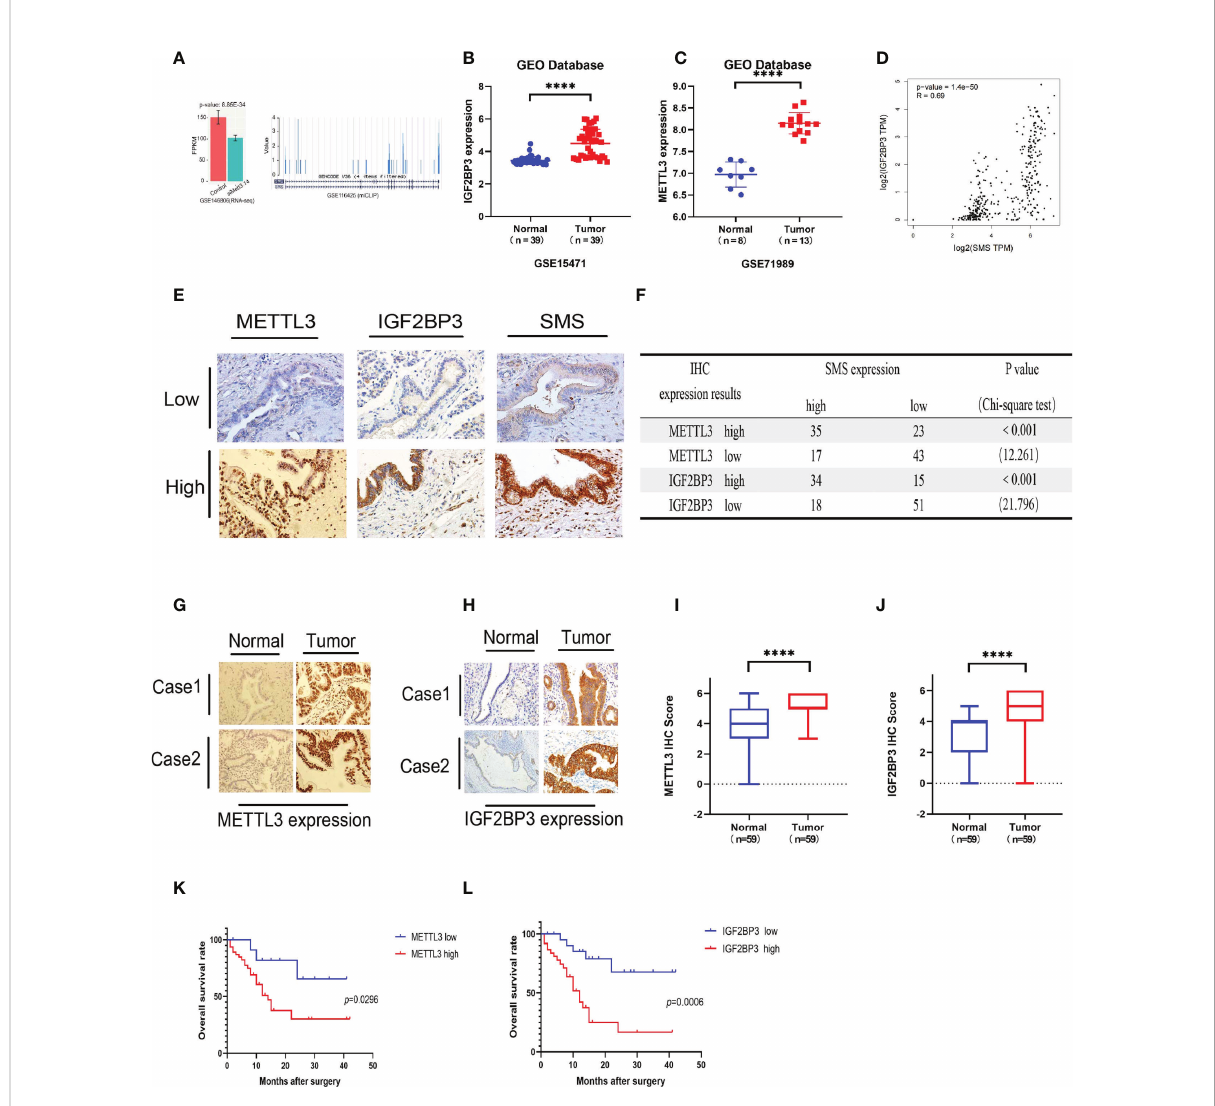
FIGURE 4 METTL3 and IGF2BP3 are highly expressed in pancreatic cancer and predicts poor prognosis of pancreatic cancer patients. (A) The expression of SMS in the METTL3 and METL14 double knock chips in the GEO database. (B, C) The expression of METTL3 and IGF2BP3 in cancer tissues and adjacent tissues. (D) The GEPIA database showed that IGF2BP3 was positively correlated with SMS mRNA expression. (E) The expressions of METTL3/IGF2BP3 and SMS in tissues of PDAC patients were evaluated by IHC. (F) The correlation between METTL3/IGF2BP3 and SMS levels in tissues was analyzed. (G-J) The expression of METTL3 and IGF2BP3 in pancreatic cancer tissues was higher than that in adjacent tissues by IHC, and the relative METTL3/IGF2BP3 staining intensity was scored. (K, L) Kaplan – Meier analyses of the correlations of METTL3/IGF2BP3 expressions and overall survival of PDAC patients. ****P <